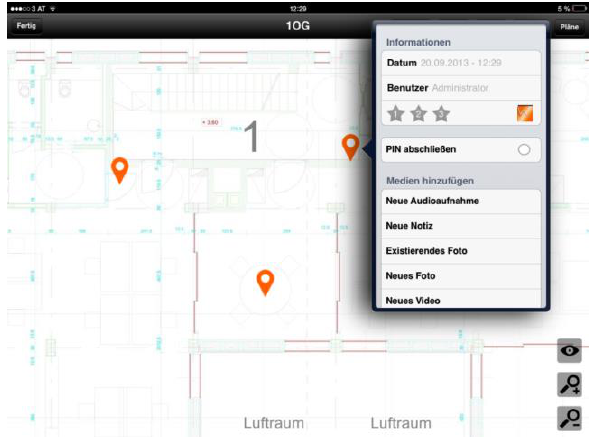
Figure 5. Docu-tools® pins within the digital plan document of